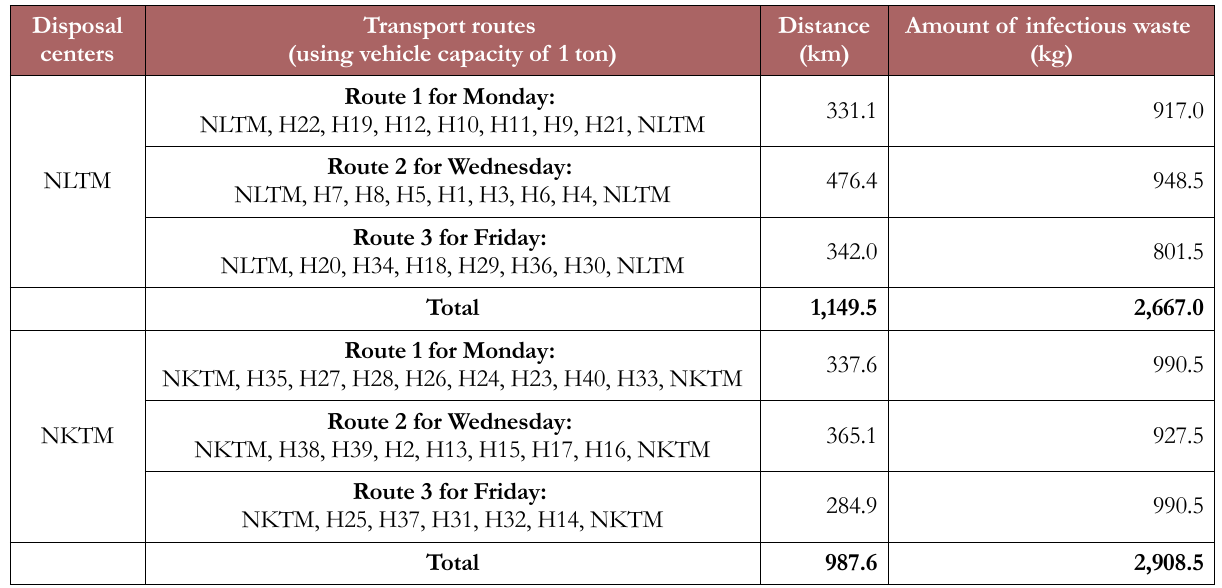
Table 12. Details of computational results for the actual problem using hybrid